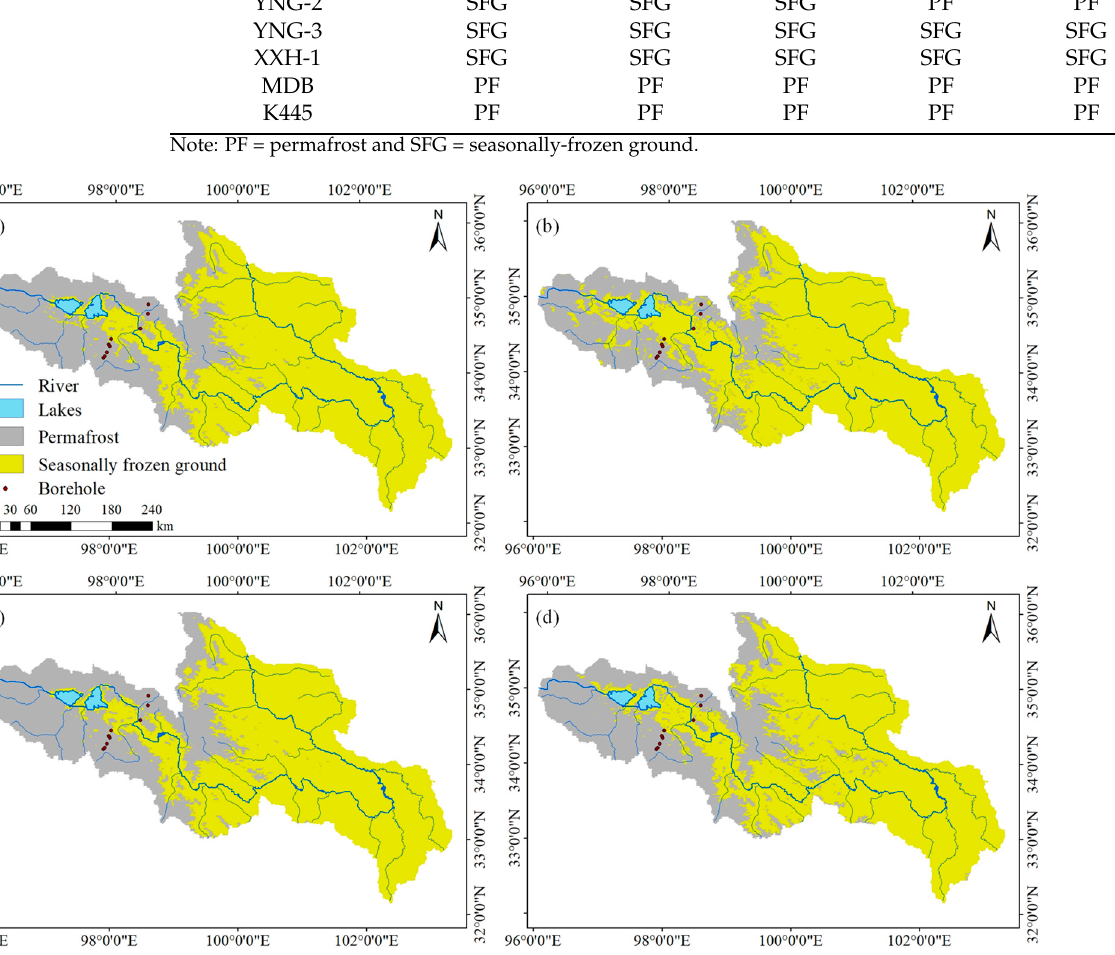
Figure 8. Map of the distribution of the frozen soil in the period from 2005 to 2014 in the SRYEARS: ( a ) the normal run, ( b ) exp1, ( c ) exp2, and ( d ) exp3. Note: PF = permafrost and SFG = seasonally-frozen ground.